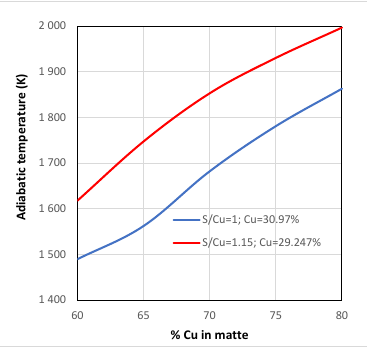
Figure 1. Adiabatic temperature of the reactive system during smelting (oxidation process) of concentrates 1 and 2 (Table 1). The enriched air for the process has 65% O 2(g) (pO 2(g) = 0.65).